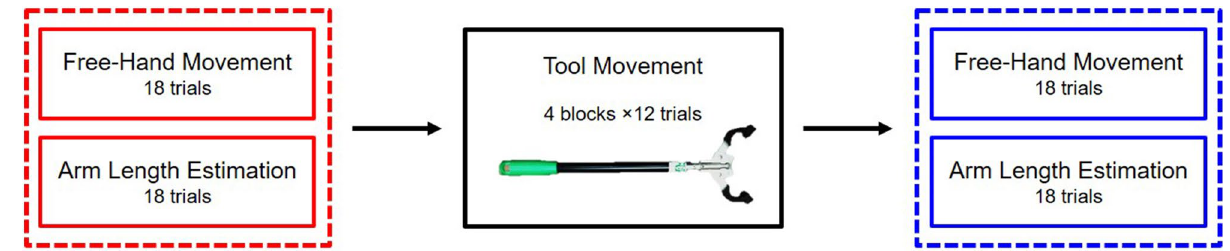
Figure 1. Experiment timeline. The tool use session included 4 blocks of 12 trials. Pre and post tool use sessions consisted of 18 free-hand reach-to-grasp movements and arm length estimation trials. The Free- Hand Movement and the Arm Length Estimation tasks were run by blocks in a counterbalanced order across